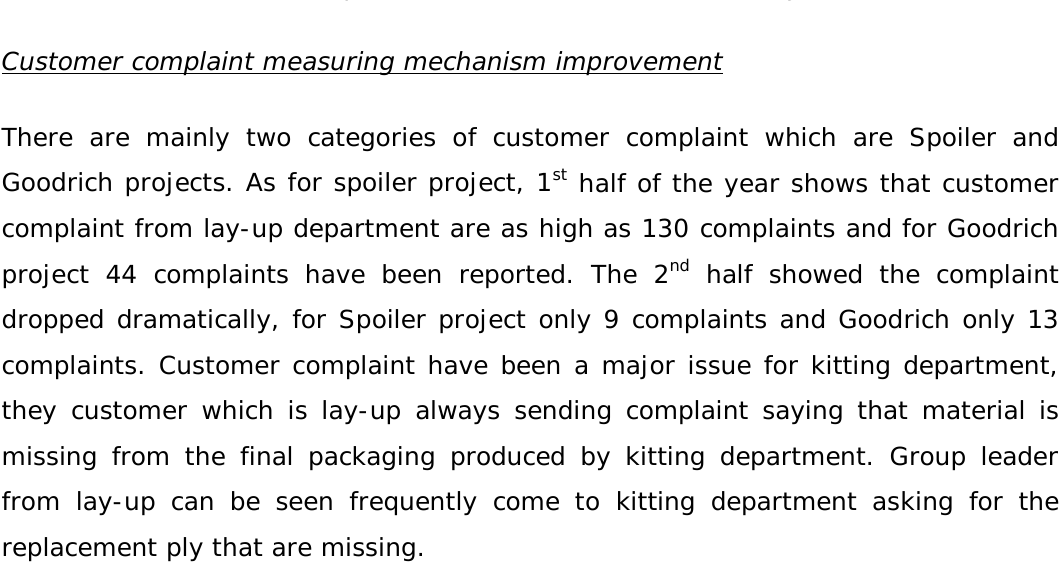
Customer Compliant Trend for Kitting